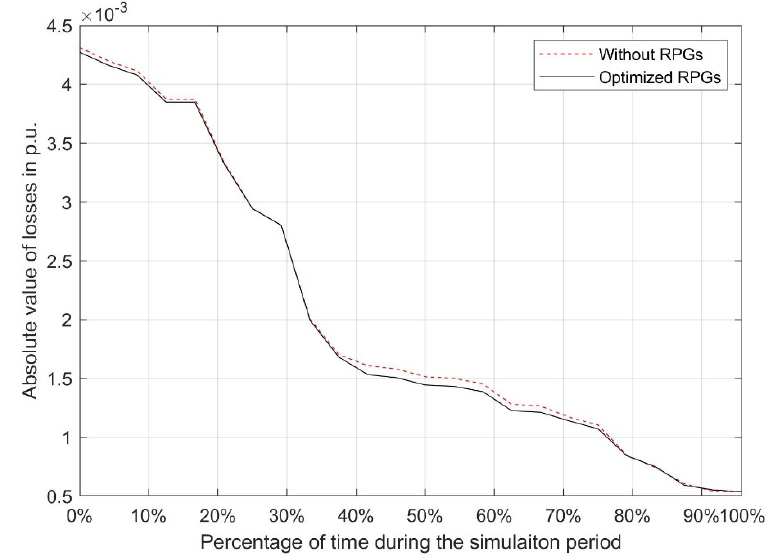
Figure 18. Loss reduction in the IEEE 14-bus system.